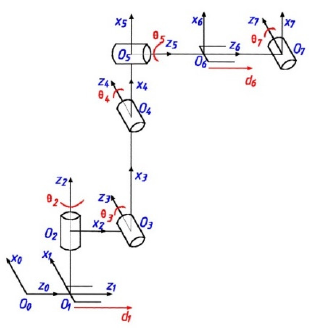
Figure 2. Schematic of the robot mechanism.